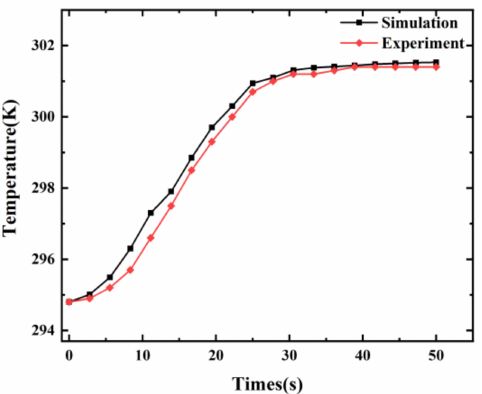
Figure 5. Simulation and experimental results on the average temperature of the outlet